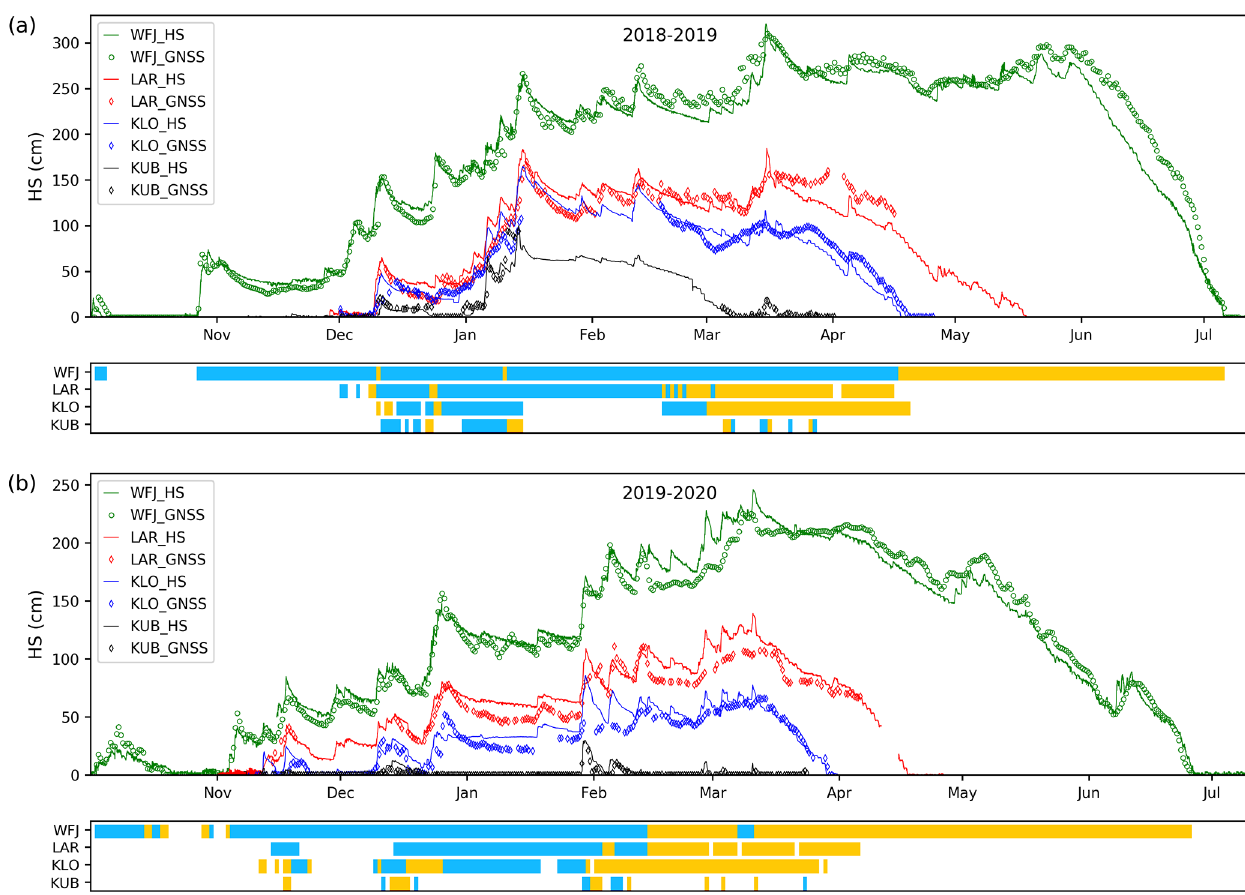
Figure 7. GNSS-derived snow depth (HS) and reference data for (a) the 2018–2019 winter and (b) 2019–2020 winter for Weissfluhjoch 2540ma.s.l. (WFJ), Laret 1510ma.s.l. (LAR), Klosters 1185ma.s.l. (KLO) and Küblis 820ma.s.l. (KUB). The color bars indicate whether the dry-snow (blue) or wet-snow (orange) GNSS algorithm was